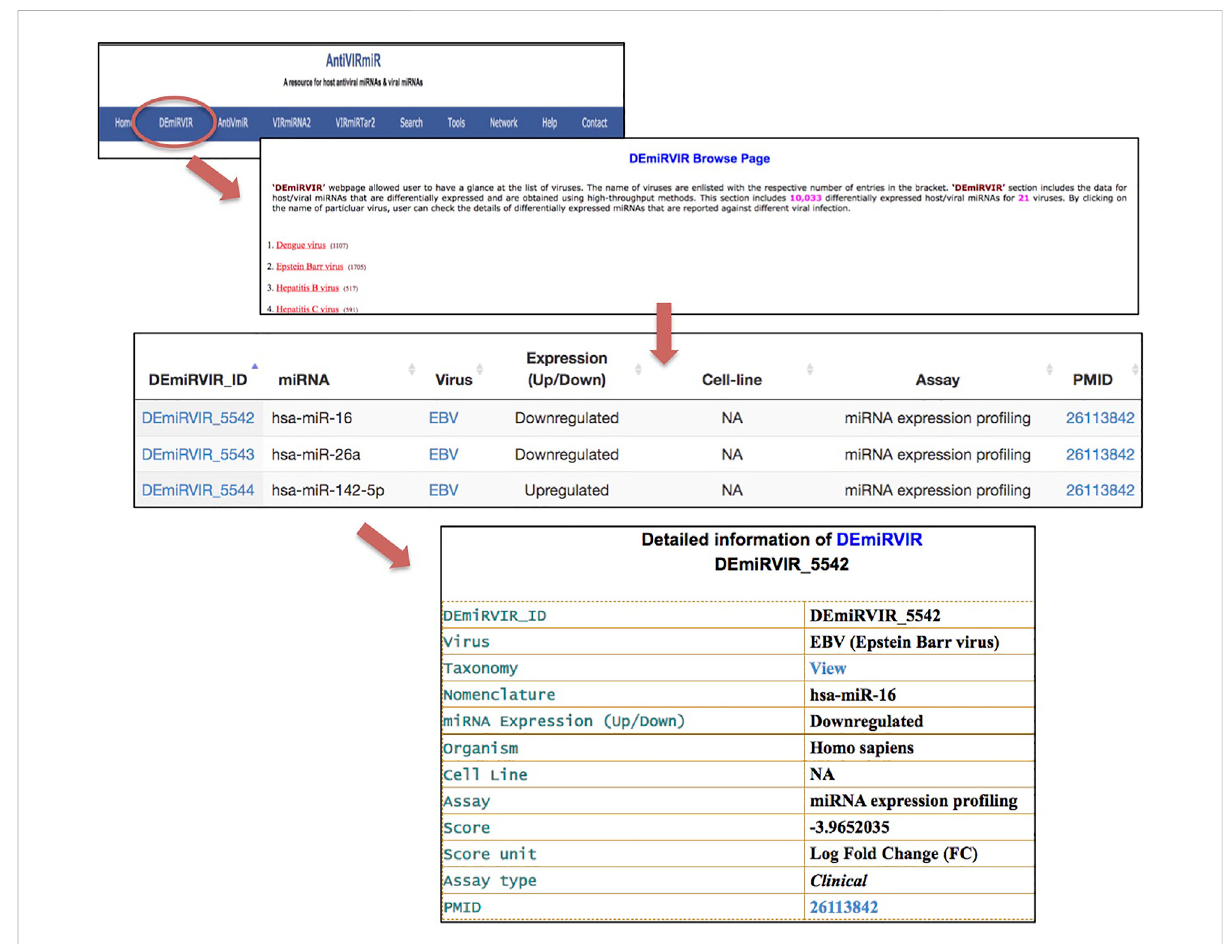
FIGURE 5 ‘ AntiVIRmiR ’ resource overview that includes a browse page, individual search output and detailed information of a miRNA